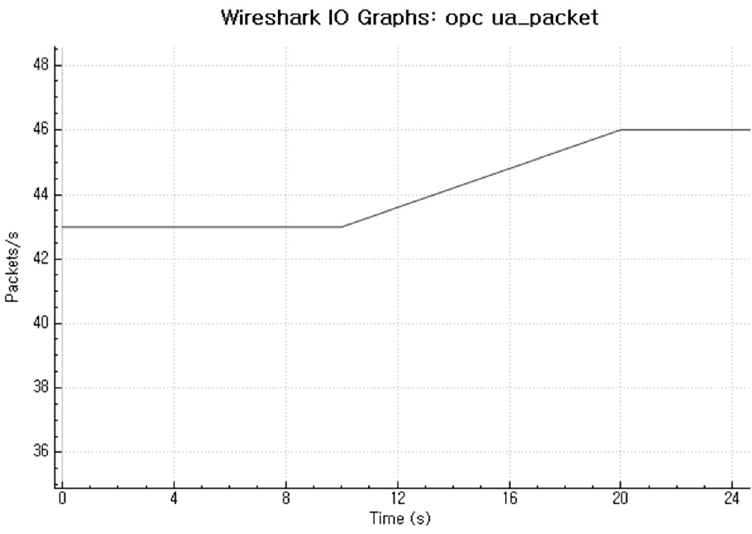
Figure 18. Wireshark IO graphs: OPC UA packet (UA Expert—OPC UA server module).